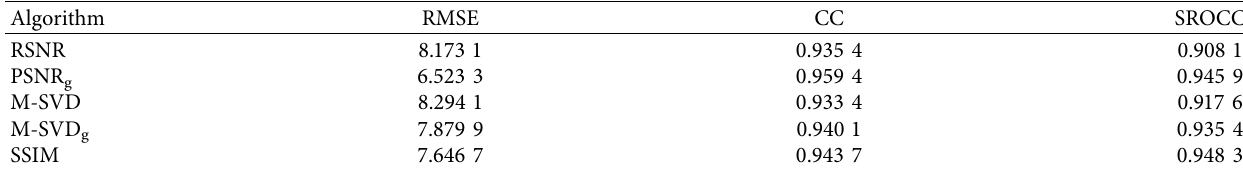
Table 1: Comparison of evaluation performance of image quality evaluation